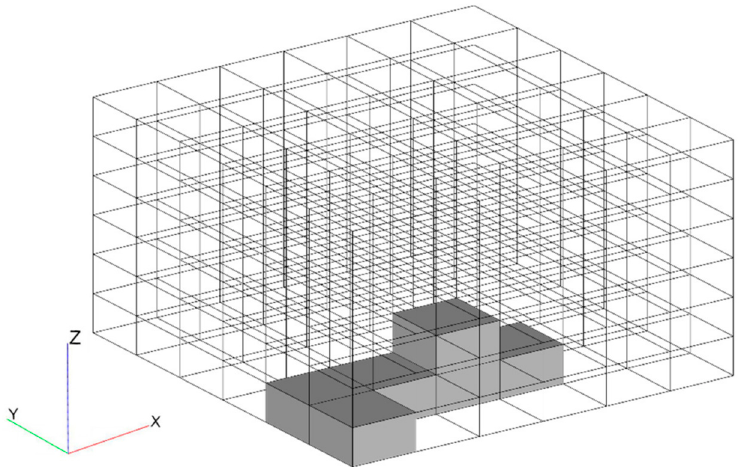
Figure 3. The batch.